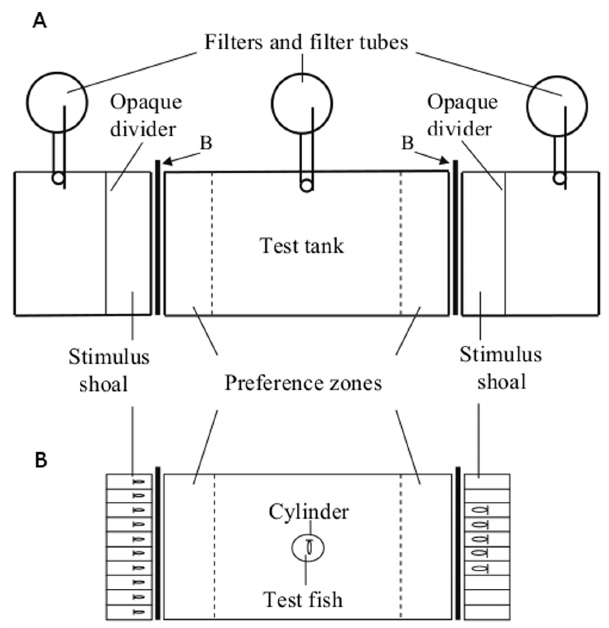
Figure 2. The experimental apparatus. (A) Diagram of the experimental apparatus showing the central test tank and the two stimulus tanks at each end of the test tank. Removable opaque white dividers were used to separate a 10-cm compartment close to the test tank, where the stimulus shoals were presented to the test fish. Opaque white barriers (B) were used to visually isolate the two stimulus tanks (containing the stimulus shoals) from the test tank. These barriers were removed when preference tests commenced. The time test fish spent within 10 cm of the stimulus shoals (preference zones) was recorded. (B) The test tank and the stimulus compartments. Diagram showing the test tank and the two stimulus compartments at each side. To simultaneously control for several continuous variables, the stimulus compartments were divided into 10 identical sectors by transparent Plexiglas partitions and each fish of the stimulus shoals was individually placed into each of the adjacent sectors. An example of 5 vs. 10 fish contrast is shown (Exp. 1). When shoals of 2 vs. 3 fish were contrasted (Exp. 2), fish were placed into the adjacent central sectors.